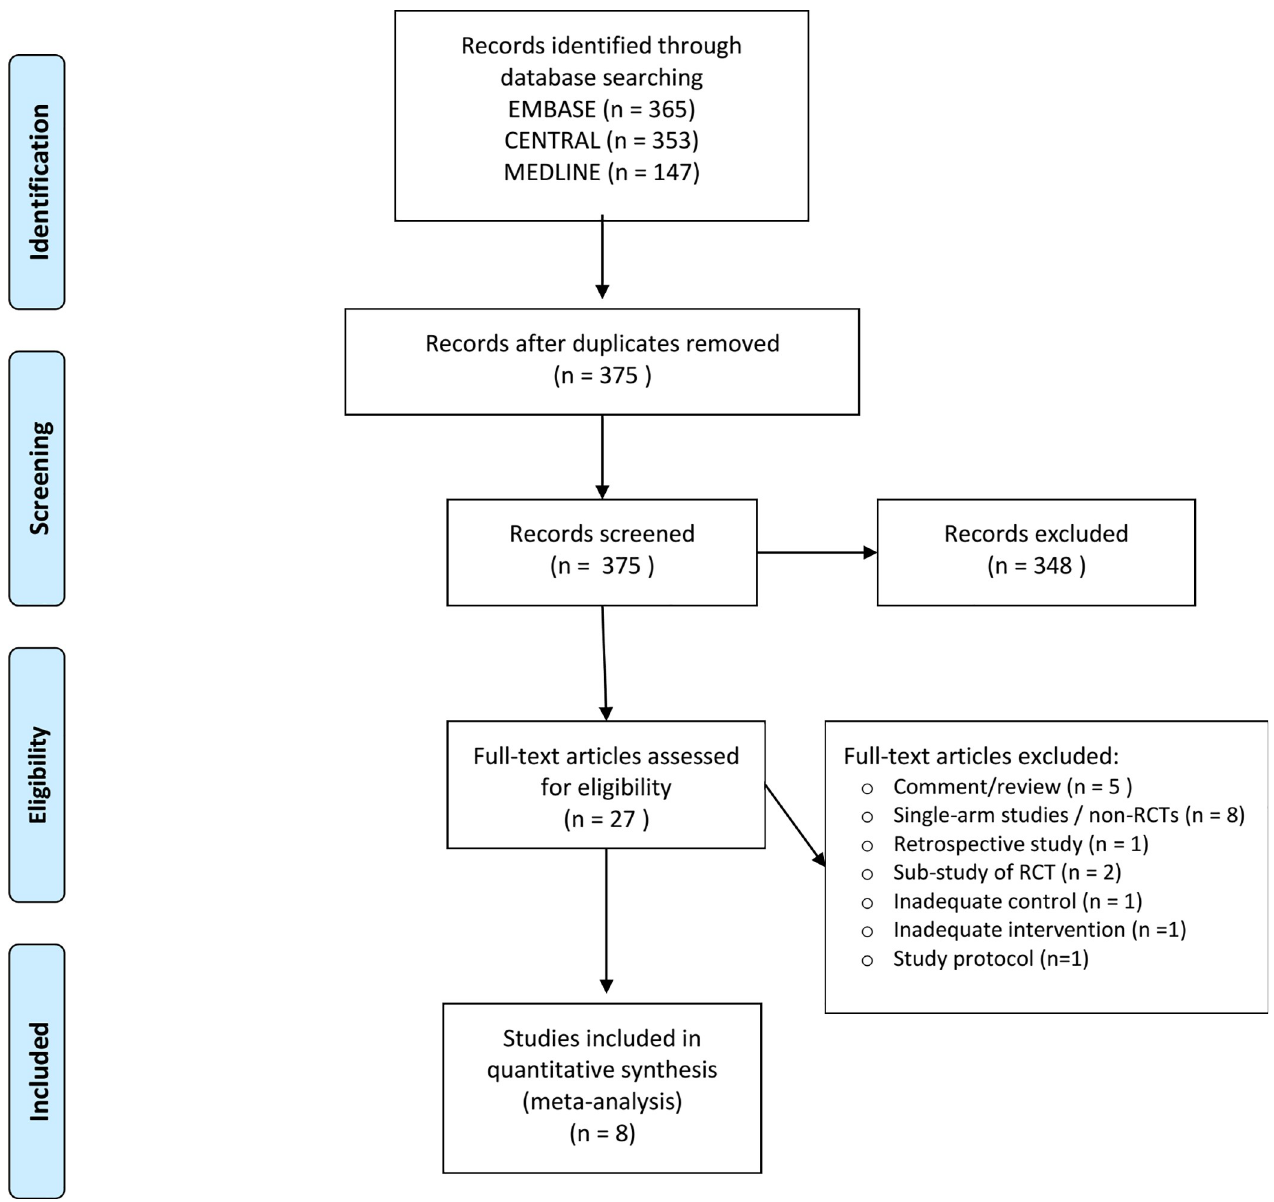
Fig 1. Flowchart of studies